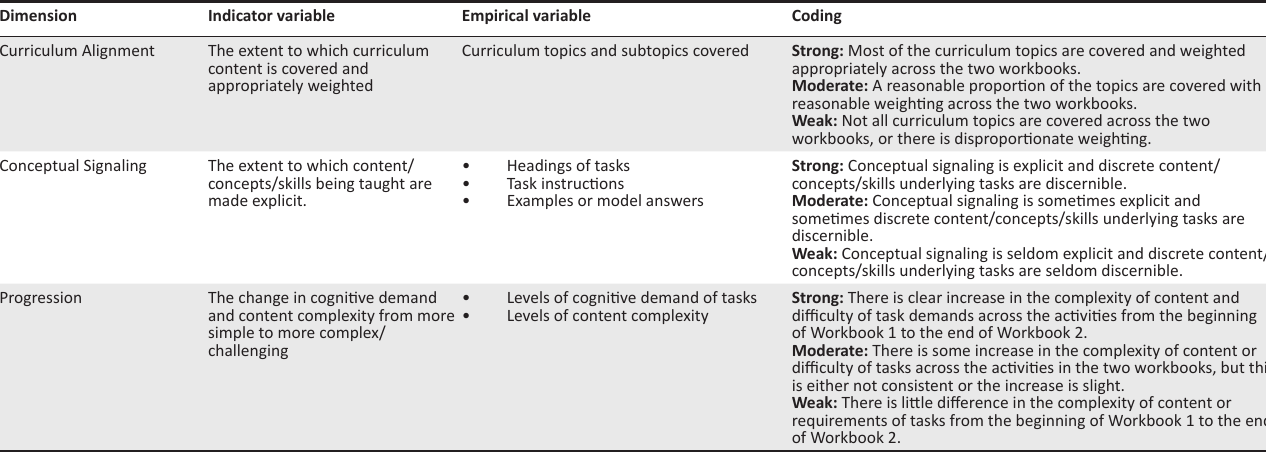
TABLE 2: Analytic framework for analysis of workbooks.